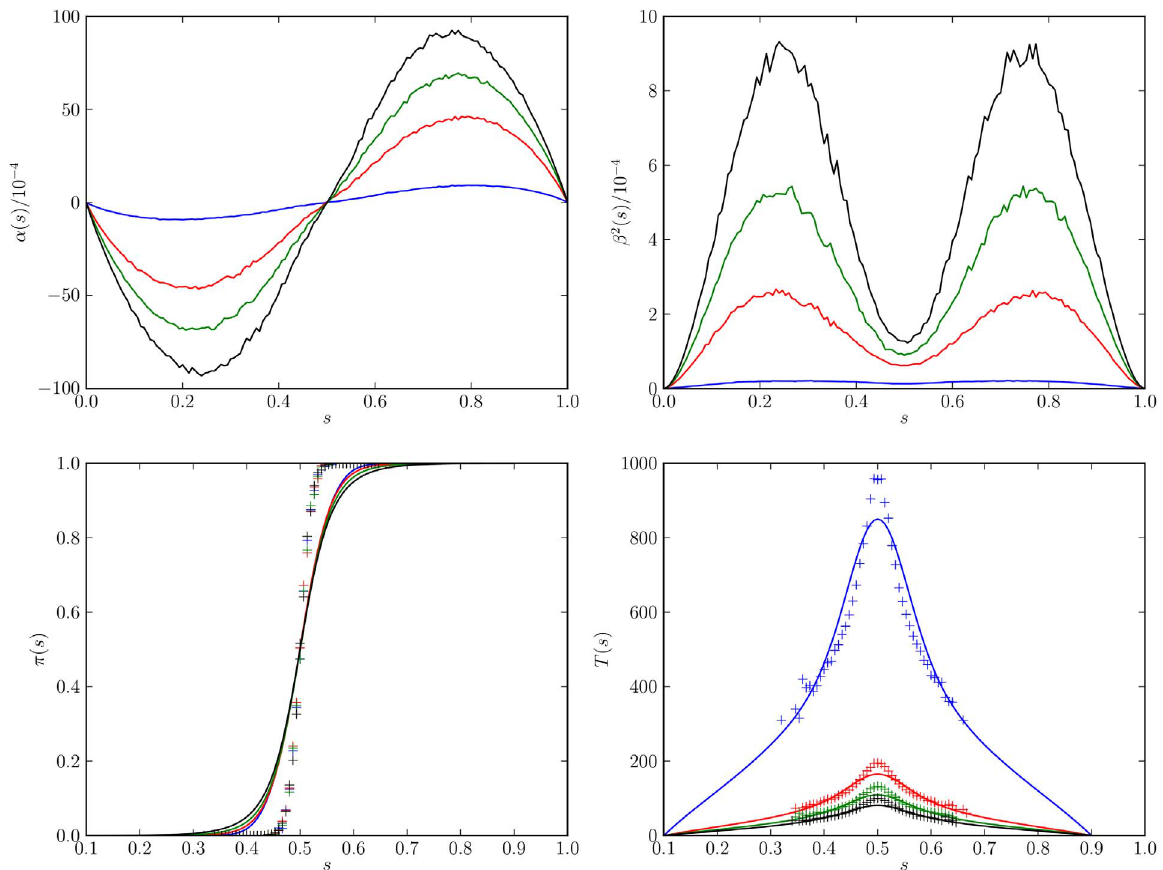
Figure 11. Comparison of swarm properties for macroscopic-discrete simulations of the virtual swarm using different values of the avoidance radius d a . Shown are results for d a ~ 0 : 01 (blue curves and markers), d a ~ 0 : 05 (red curves and markers), d a ~ 0 : 075 (green curves and markers) and d ~ 0 : 1 (black curves and markers). All other simulation parameters are given in table 3. (top panels) Parameters a ( s ) (left) and b 2 ( s ) (right) for the stochastic differential equation as inferred from the simulation results for the virtual swarm. (bottom left panel) Splitting probability p ( s ) , as estimated directly from the simulation output [cf. Eq. (53)] (markers) and computed using the integrated stationary distribution Eq. (54) (curves). (bottom right panel) Decision time T ( s ) as estimated from the simulation output [Eq. 58] (markers) and computed from the FPE coefficients [Eq. (59)] (curves).